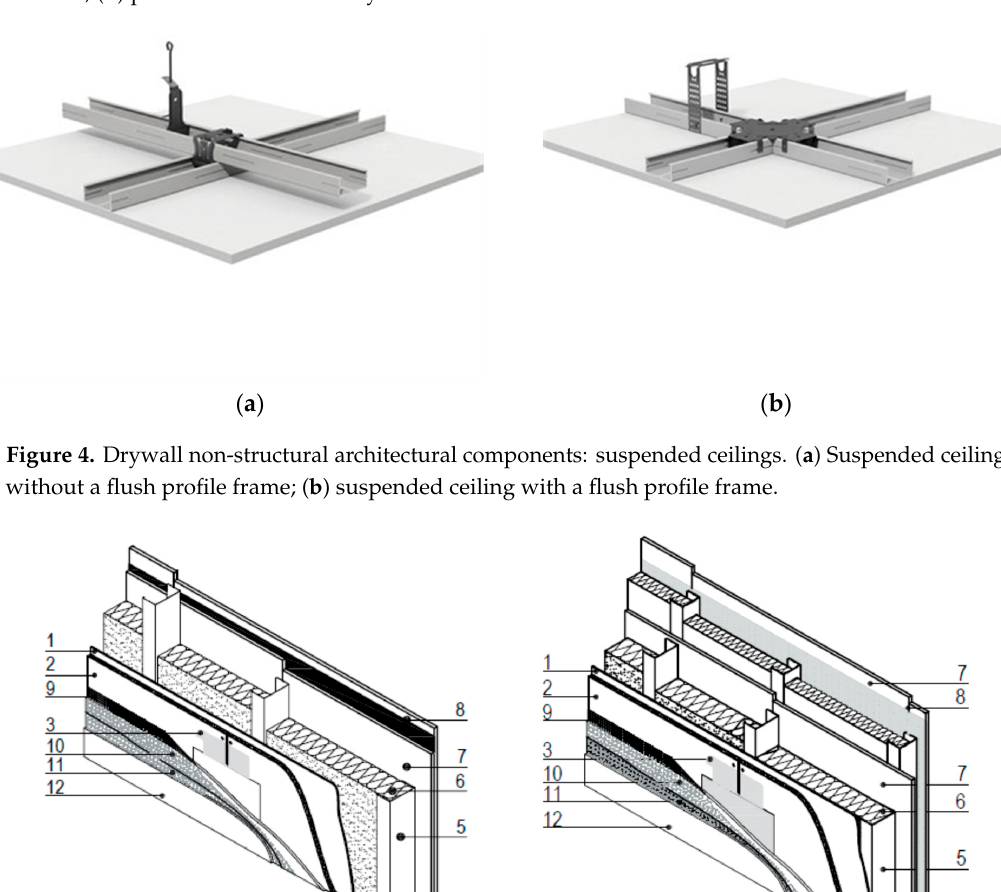
Figure 3. Drywall non-structural architectural components: partitions. ( a ) Partition with single layer of studs; ( b ) partition with double layer of studs.